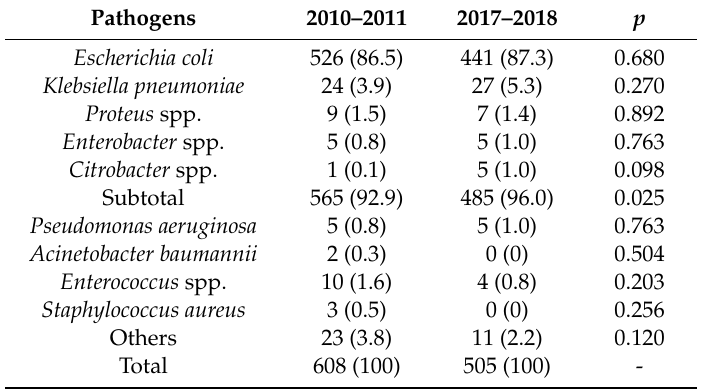
Table 1. Comparison of the aetiologies of community-acquired acute pyelonephritis.